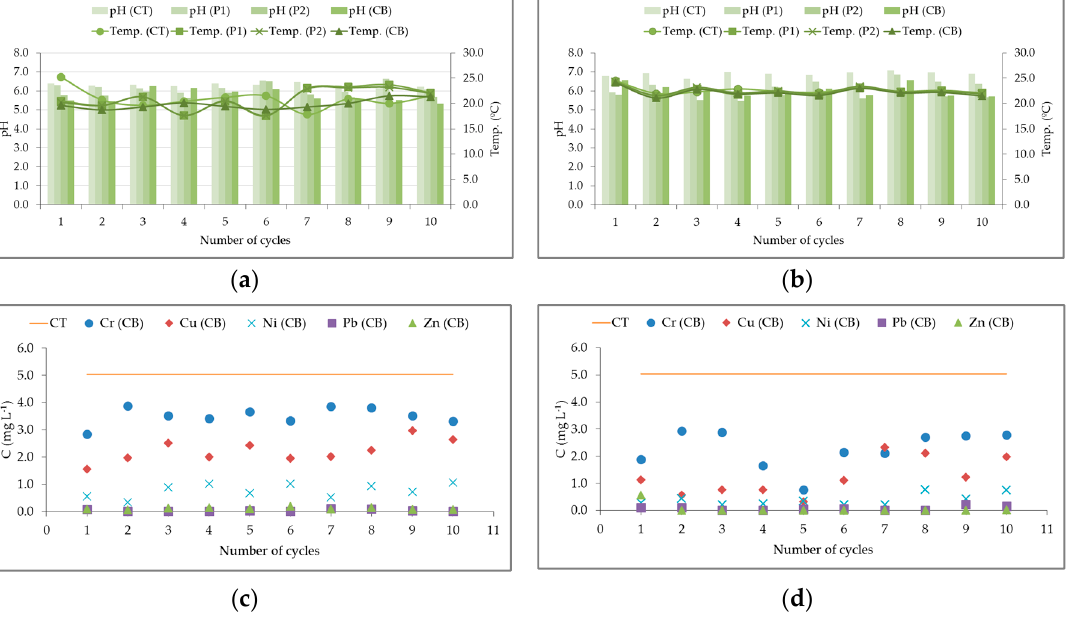
Figure 2. pH and temperature variation in the sampling points for the: ( a ) discontinuous mode and ( b ) continuous mode experiments; Variation of the concentration of Cr, Cu, Ni, Pb and Zn at the CB point for the: ( c ) discontinuous mode and ( d ) continuous mode